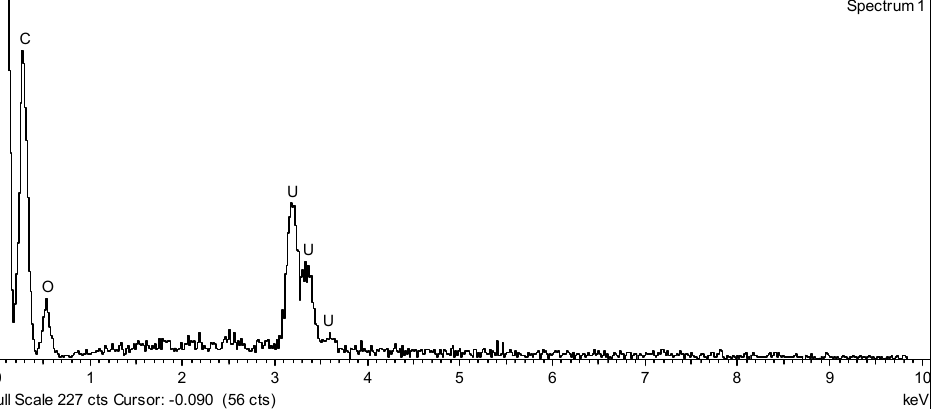
Figure 3. EDX spectrum of the UC 2 − y material before laser heating, showing the presence of uranium, oxygen, and carbon.